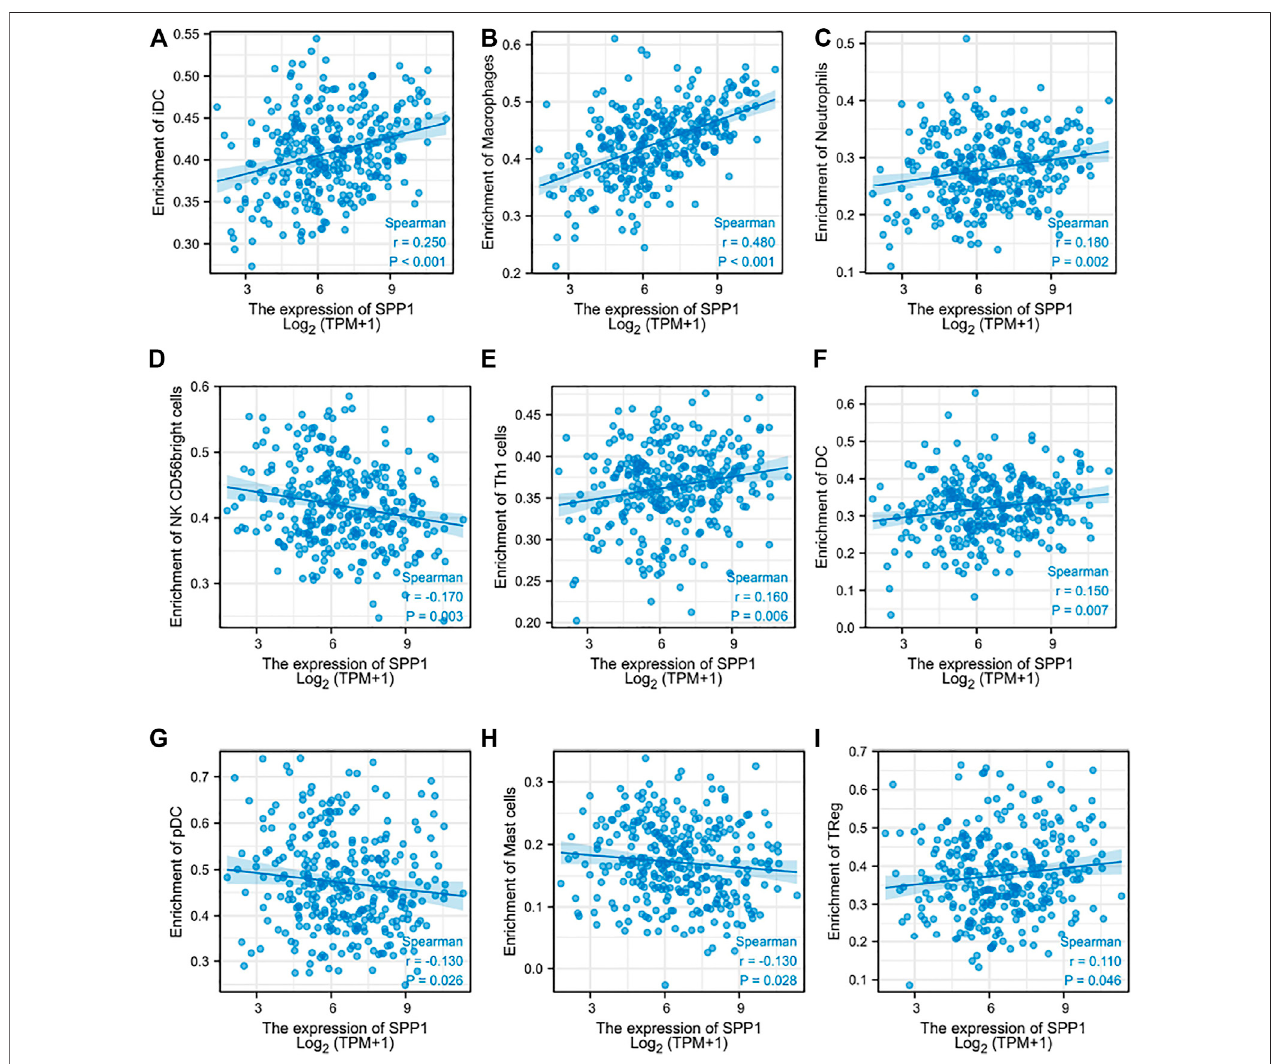
FIGURE7| Correlationbetween SPP1 expressionandimmunecellin fi ltration. (A – I) Correlationbetween SPP1 expressionandiDC,macrophages,neutrophils,NK CD56 bright cells, Th1 cells, DC, pDC, mast cells, and Treg cells.